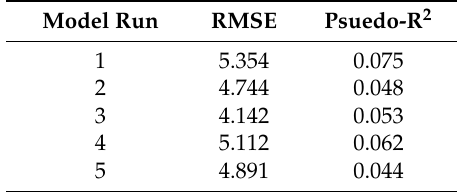
Table 5. RMSE as calculated by Crossfold model